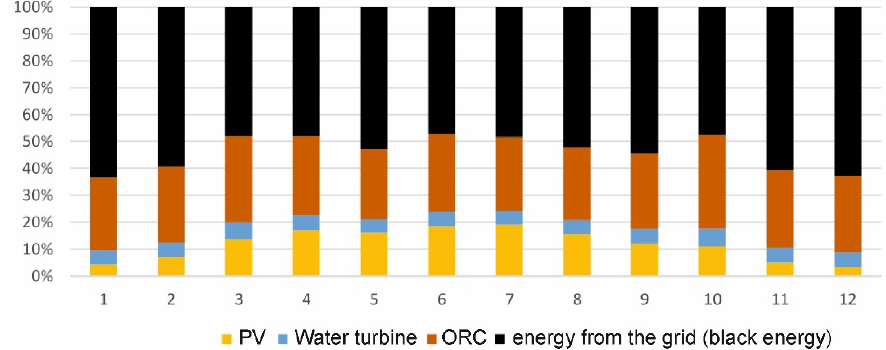
Figure 4. Current share of RES in terms of electricity consumption at the existing ChT facility. Due to the nature of the heat source, which comes from the extraction of geothermal water at a temperature of 88 ◦ C, the development of a concept for utilizing this heat requires that attention be paid not only to the need for thermal power but also—and above all—to the temperature range of the individual receivers. It should be noted that the total available thermal output of a geothermal source, calculated as the product of the water mass flow (a maximum of 160 t/h is assumed), the specific heat of the water, and the temperature difference (between the geothermal water temperature of 88 ◦ C and